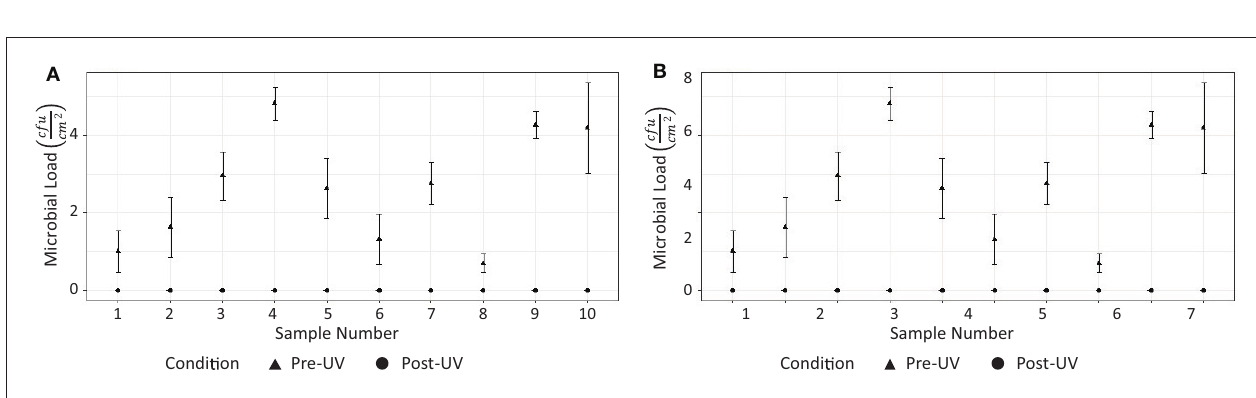
FIGURE 5 | Effectiveness of UV irradiation at eliminating on bacterial load on surfaces in hospital 1: (A) CT suite, (B) X-ray suite. locations, were chosen in advance to maximize the total surface area exposed to UV irradiation. The robot stopped for a